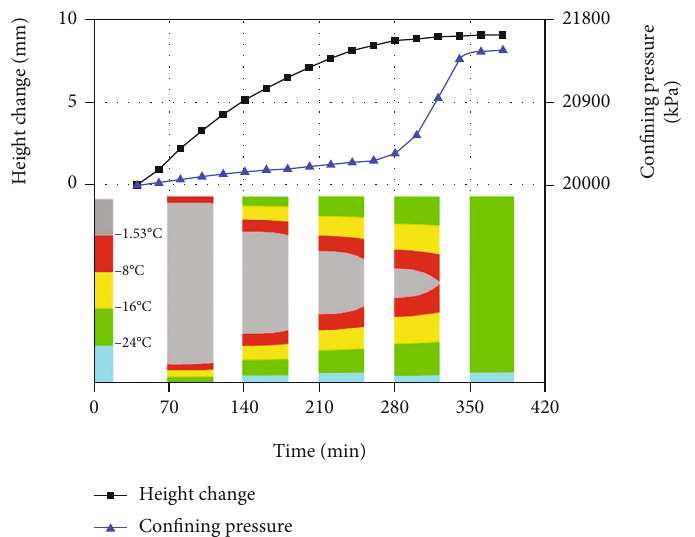
Figure 17: Changes in the simulated freezing state of the sample, the measured sample height, and the measured con fi ning pressure over time under the condition that the mean temperature of the con fi ning medium was controlled but the sample was frozen with two freezing fronts developing towards each other. The freezing state of the sample is shown through an axisymmetric plane, and the time corresponds to the symmetry axis (left border of the